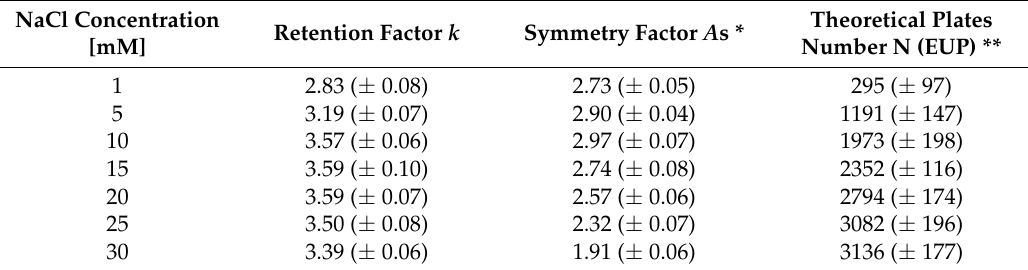
Table 1. Effect of NaCl concentration in the mobile phase in the range of 1 to 30 mM for the KI retention factor ( k ), the peak symmetry factor ( A s ), and the theoretical plates number (N). The column was IAM.PC.DD2 Regis HPLC Agilent Technologies, flow rate of the mobile phase was 0.5 mL/min, injected volume 3 µ L, and analytical wavelength of 226